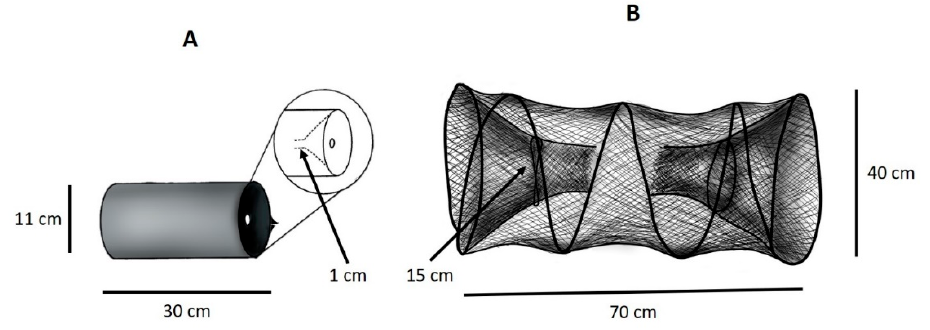
Figure 2. Benthopelagic macrofauna trap ( A ) and Megafauna trap ( B ).